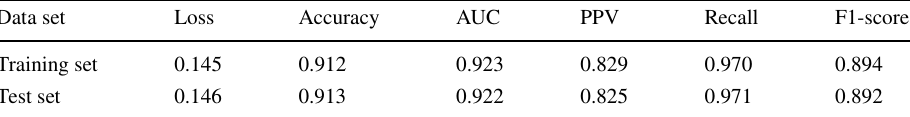
the model on the training and test sets